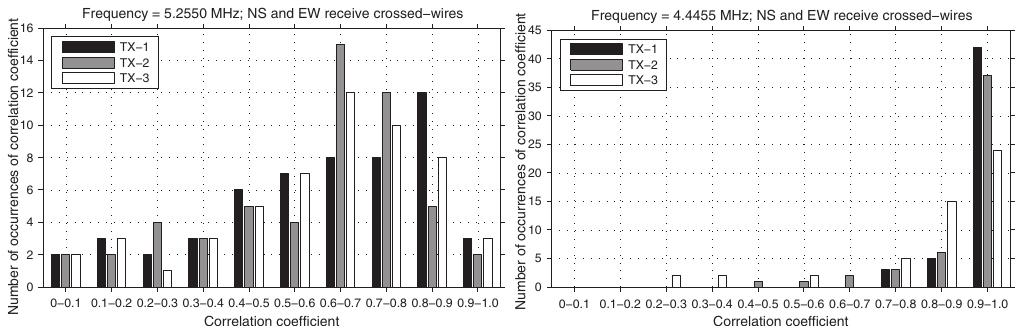
Fig. 3. The occurrence frequency histograms of the correlation coefficients between the N-S and E-W receive crossed wire antennas for each of the transmitting antennas: 3 X 5 MIMO campaign between Durham and Brunt- ingthorpe on 29 July 2008 [Left frame: 5.2550 MHz transmissions (54 one-minute data files); Right frame: 4.4455 MHz transmissions (50-one minute data files); TX-1: N-S crossed-wire (5.255010 MHz/4.445510 MHz); TX-2: E-W crossed-wire (5.255020 MHz/4.445520 MHz); TX-3: vertical antenna (5.255040 MHz/4.445540